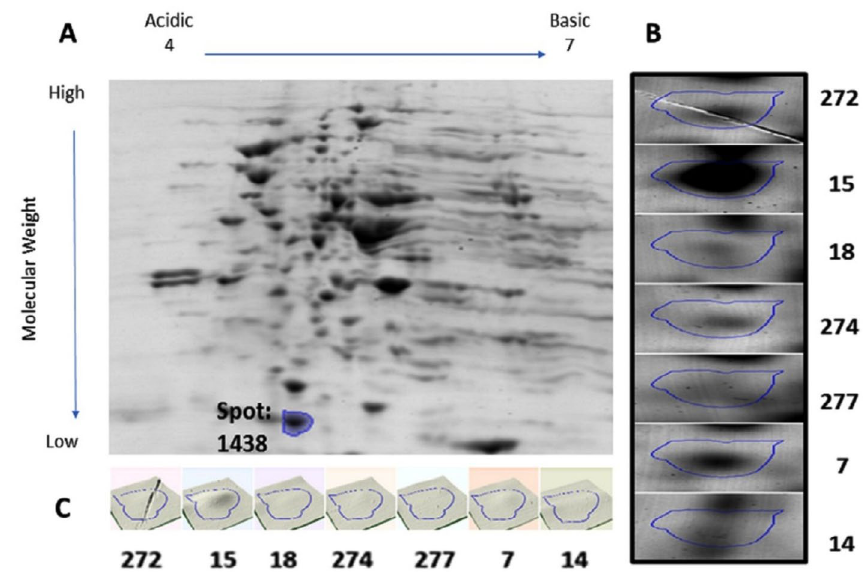
Fig. 2. 2D gel electrophoresis of gel from sample 15 (A). Comparison of spot 1438, identified as DksA, in all samples (B). 3D montage to visualize the amount of protein in each gel at the same spot